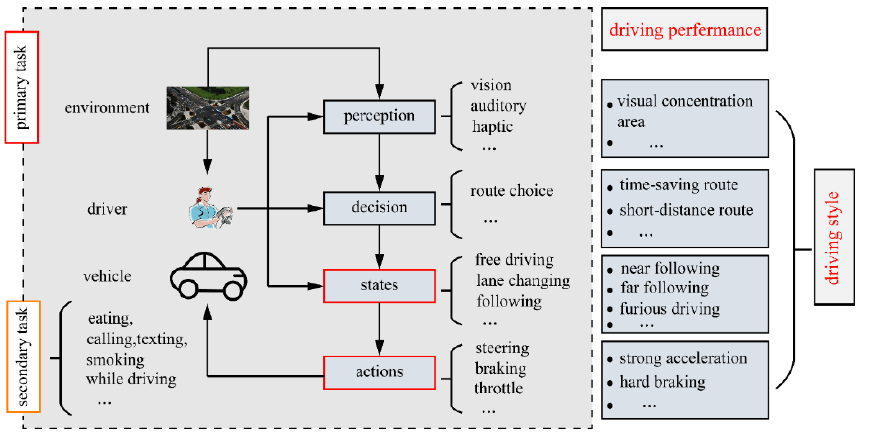
Figure 1. A framework of driving style analysis.